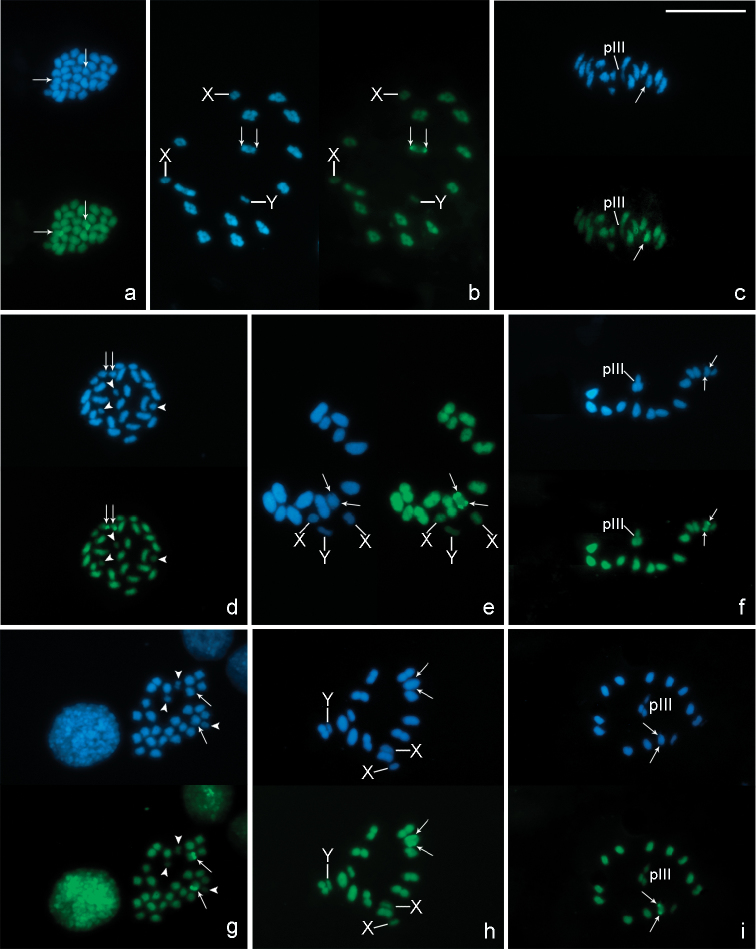
DAPI (blue) and CMA3 (green) fluorescent banding in chromosomes of Belostoma dentatum (a–c), Belostoma elongatum (d–f) and Belostoma gestroi (g–i). a Oogonial metaphase (2n = 30 = 26 + X1X1X2X2) b Diakinesis c Metaphase II d Spermatogonial metaphase (2n = 29 = 26 + X1X2Y) e Diakinesis f Metaphase II g Spermatogonial metaphase (2n = 29 = 26 + X1X2Y) h Diakinesis i Metaphase II. Arrows indicate DAPI negative/CMA3 positive bands. Arrowheads show sex chromosomes (d, g). X, Y = sex chromosomes. pIII = pseudo-trivalent. Bar = 10 µm.